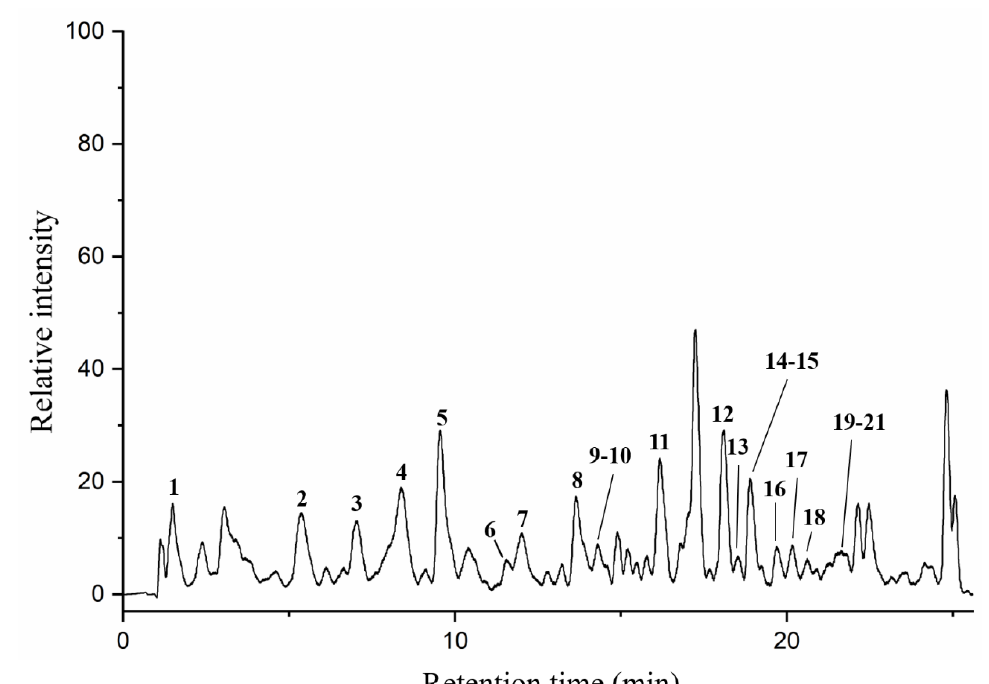
Figure 2. Total ion chromatogram (TIC) of AFH in a negative ion mode. Table 5. Characterization of the phenolic components in AFH by HPLC-DAD / QTOF-MS. Peak